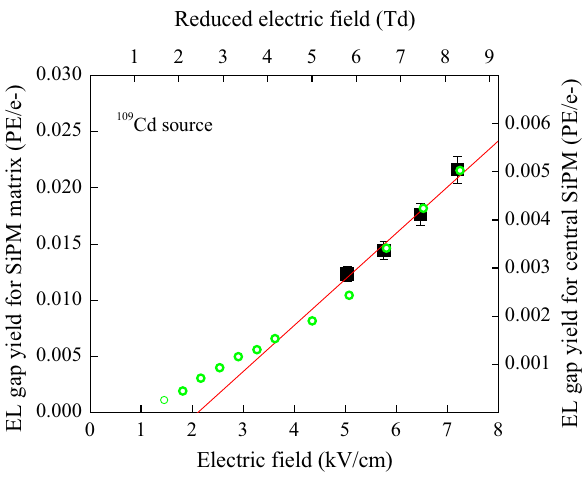
Fig. 12 DirectSiPM-matrixreadout:ELgapyieldfortheSiPMmatrix in total (solid data points, left scale) as a function of the electric field or reduced electric field in the EL gap, at the average energy of 82 keV deposited by gamma-rays from 109 Cd source in liquid Ar. The red line is a linear fit to the data points. For comparison, the EL gap yield for the central SiPM measured elsewhere [16] is shown (open data points, right